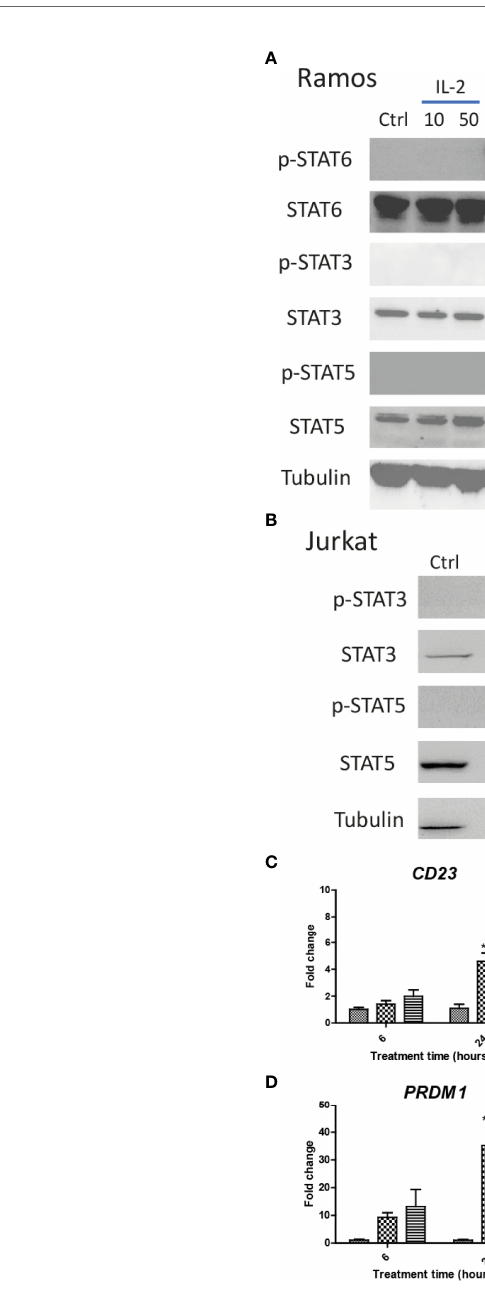
of antigen processing/presentation and the formation of ectopic germinal centers (13). Except genetic mutation, cytokine imbalance is another important factor leading to increased survival and proliferation of autoreactive B cells in these diseases.